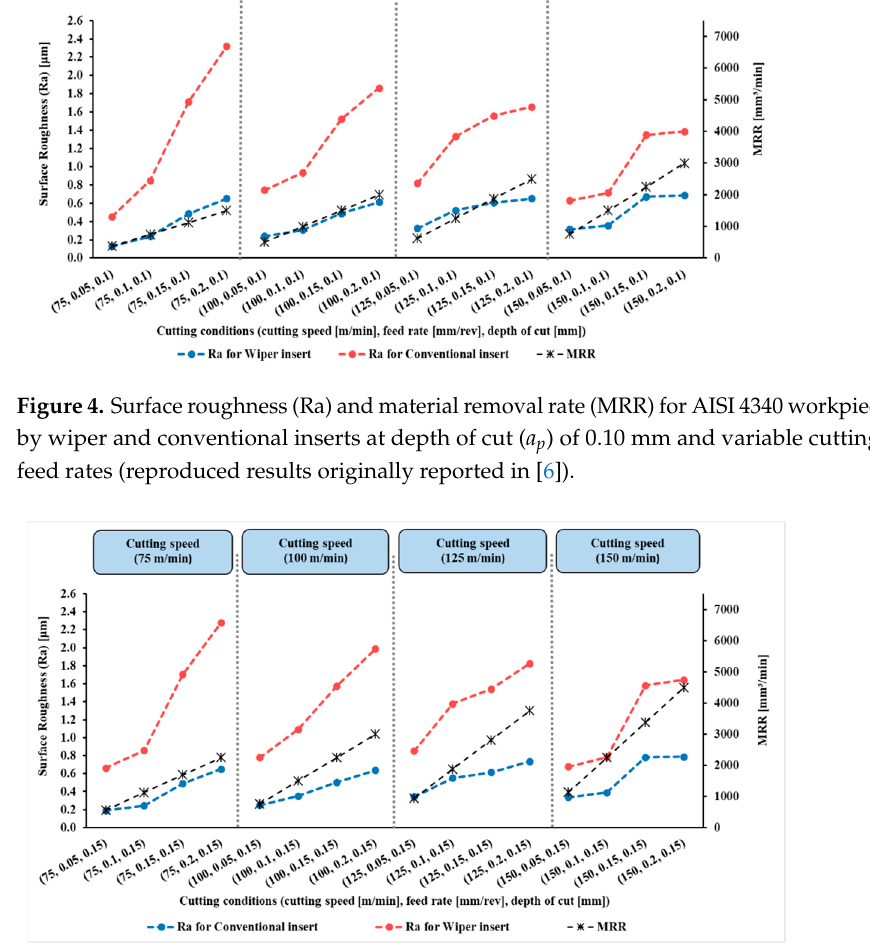
Figure 5. Surface roughness (Ra) and material removal rate (MRR) for AISI 4340 workpieces machined by wiper and conventional inserts at depth of cut ( a p ) of 0.15 mm and variable cutting speeds and feed rates (reproduced results originally reported in [6]).